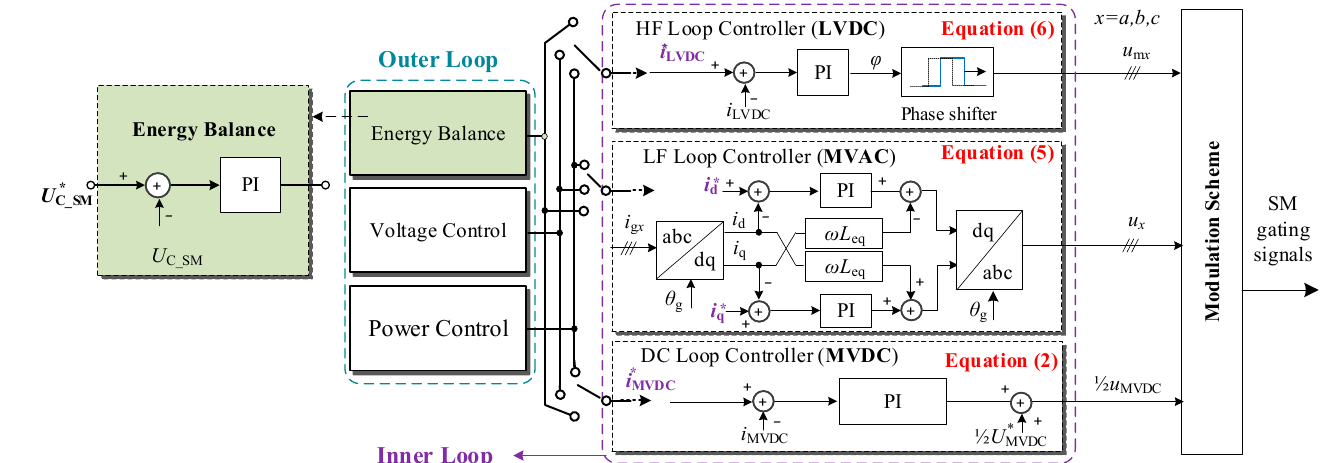
Figure 4. Multi-port control strategy (variables with * are reference values, and light green back- ground to highlight the Energy Balance block).